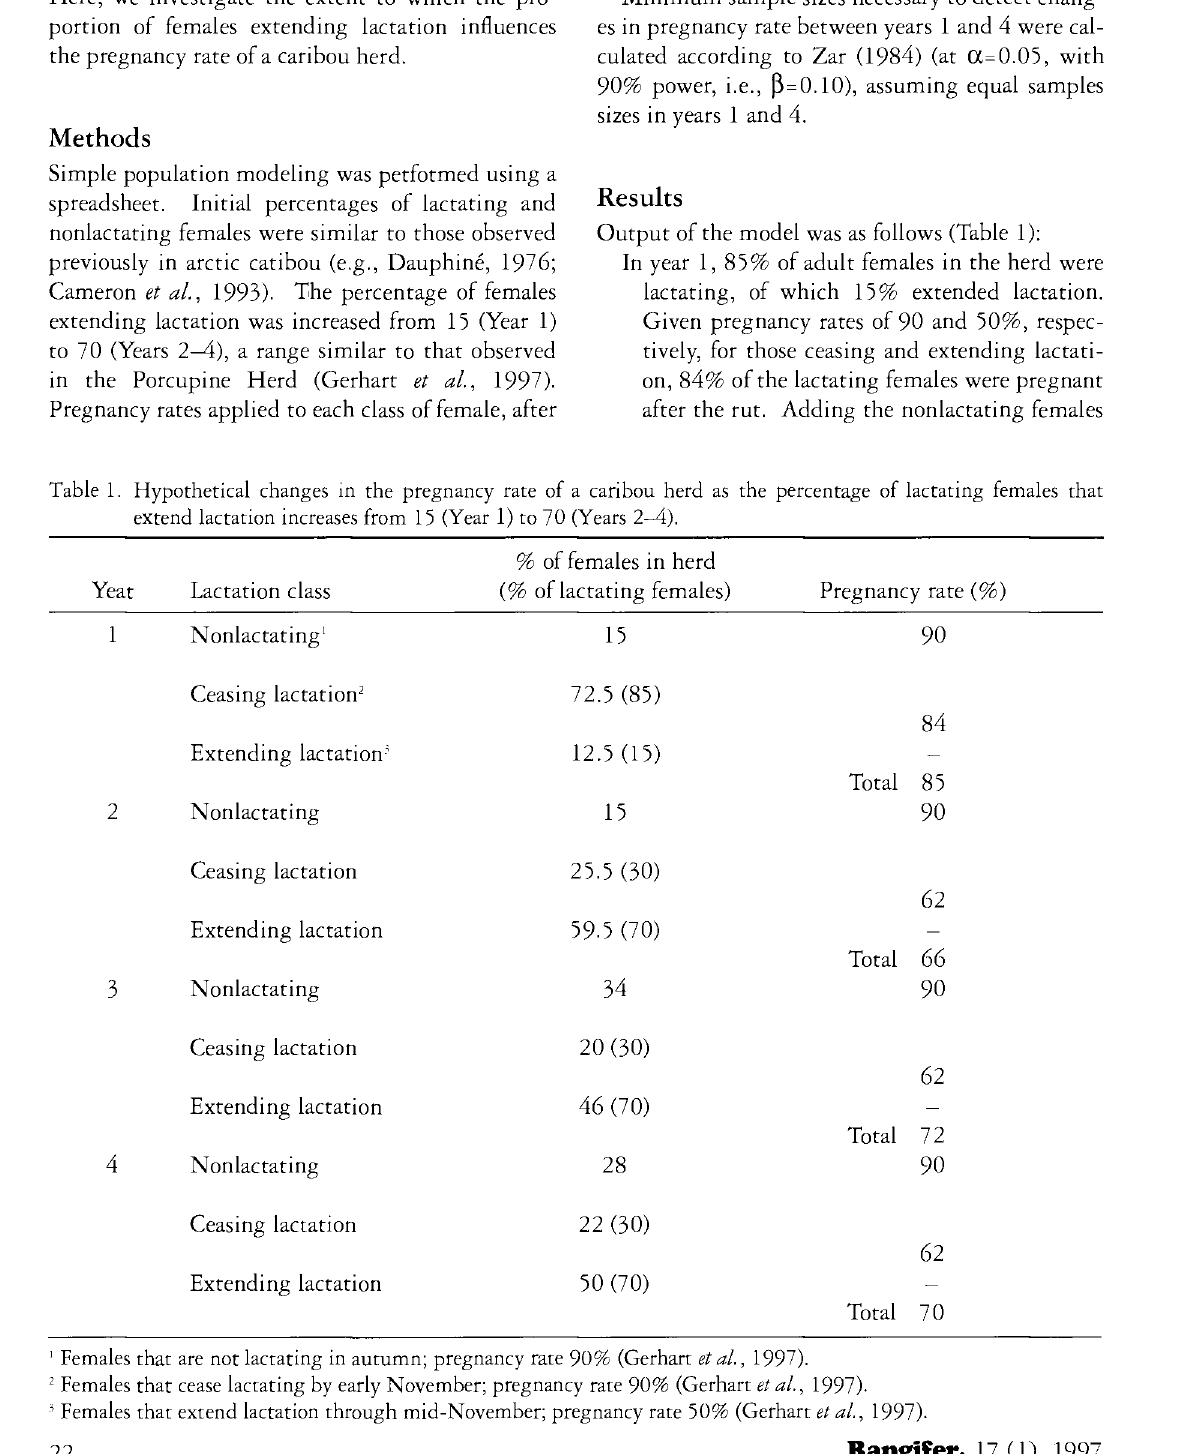
Table 1. Hypothetical changes in the pregnancy rate of a caribou herd as the percentage of lactating females that extend lactation increases from 15 (Year 1) to 70 (Years